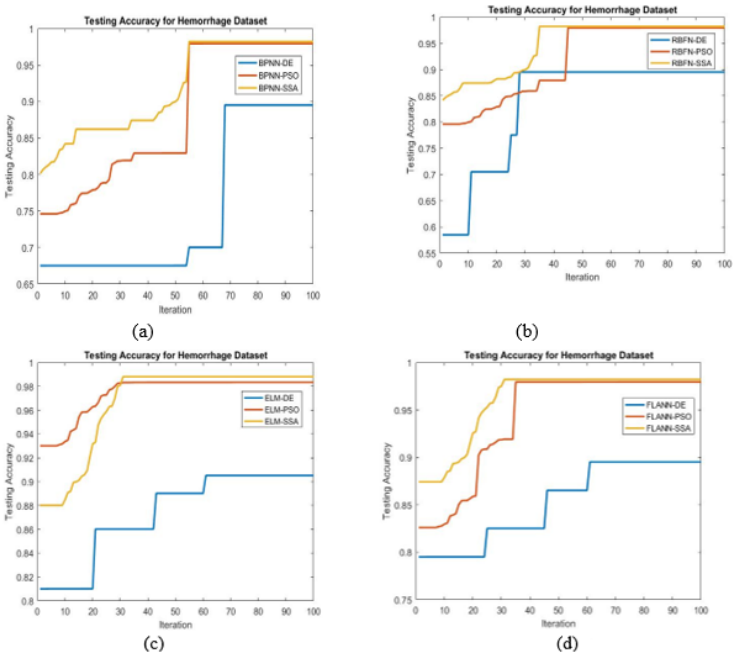
Figure 10. Comparison of Accuracy of Hemorrhage dataset using ( a ) BPNN, ( b ) RBFN, ( c ) ELM, ir ( d ) FLANN.